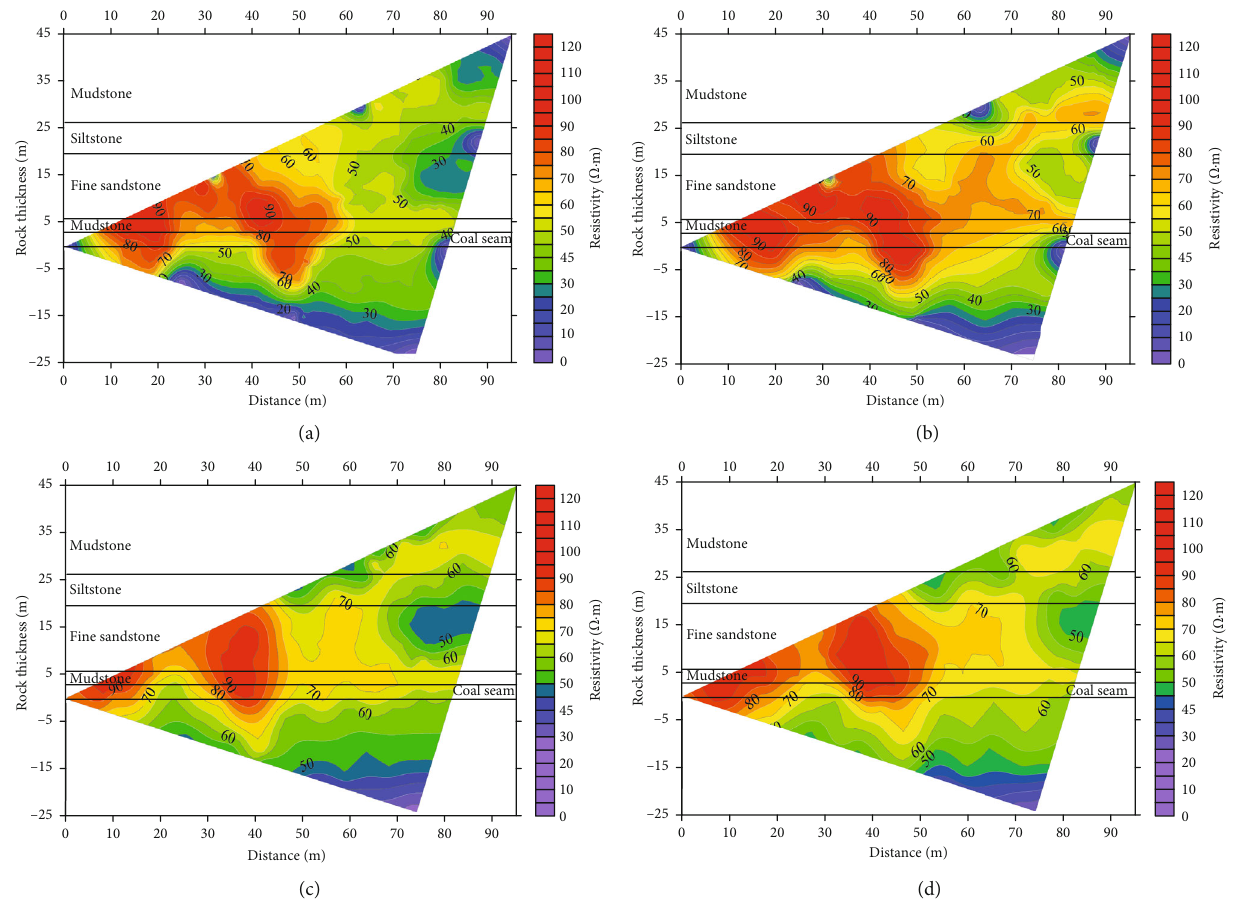
Figure 8: Detected resistivity pro fi le during the back fi ll mining: (a) 40m; (b) 60 m; (c) 70m; (d)